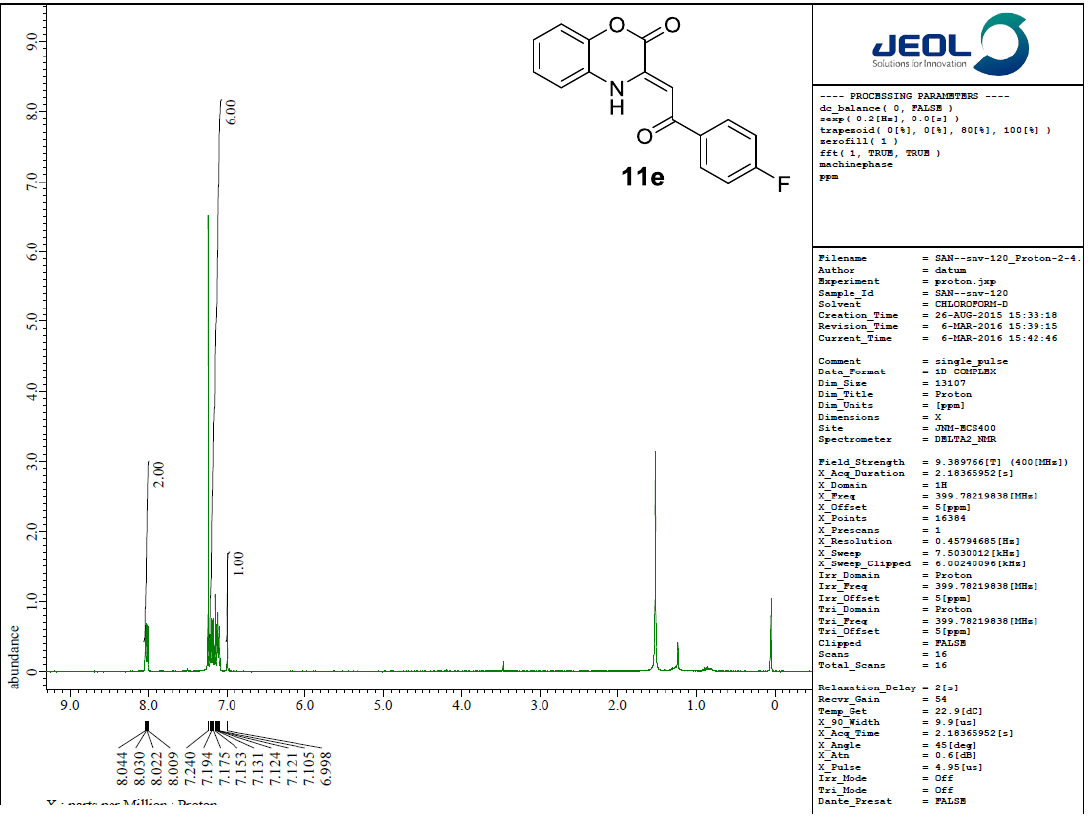
Figure 9. 1 H NMR Spectra of Compound 11e .